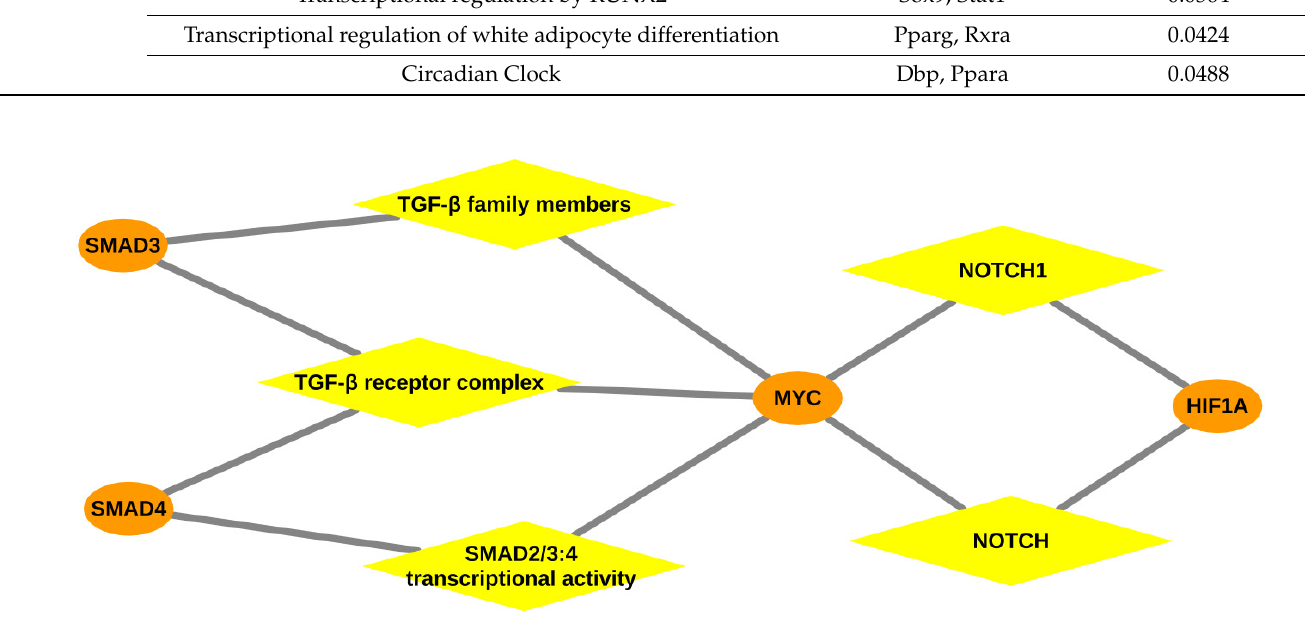
Figure 3. Gene-pathway network: Network representing the association between the over-represented pathways and transcription factors especially MYC , depicted for the liver tissue of Boran. Orange coloured ellipses in the network represent the transcription factor genes and yellow coloured rhombuses indicate the over-represented pathways. The transcription factors are connected to the pathways, thereby forming a network of interactions between